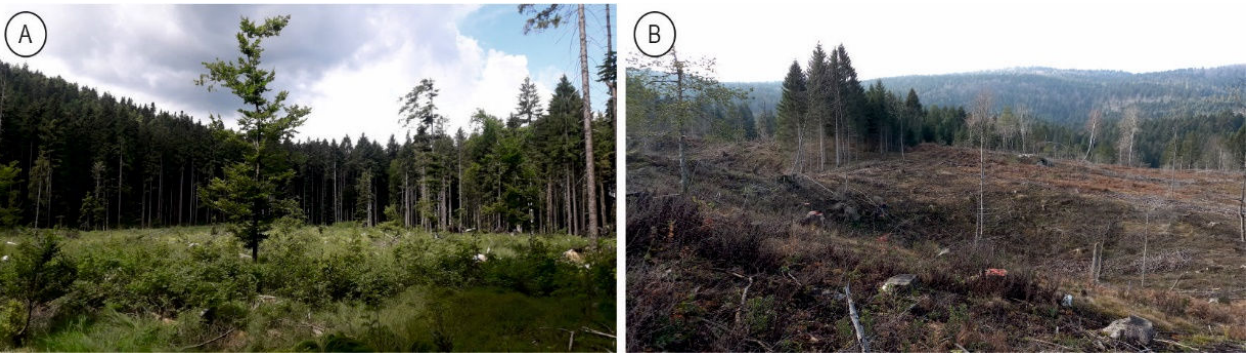
Figure 1. Study area ( A ) Plot 1—Sunger and ( B ) Plot 2—Carevići. The salvage logging in these two plots was performed in 2017 after a bark-beetle outbreak which, in the period from 2016 to 2021, affected 11,939.93 ha in the Gorski, Kotar, area and resulted in 262,927 m 3 of cut timber in salvage logging. Due to an Ips